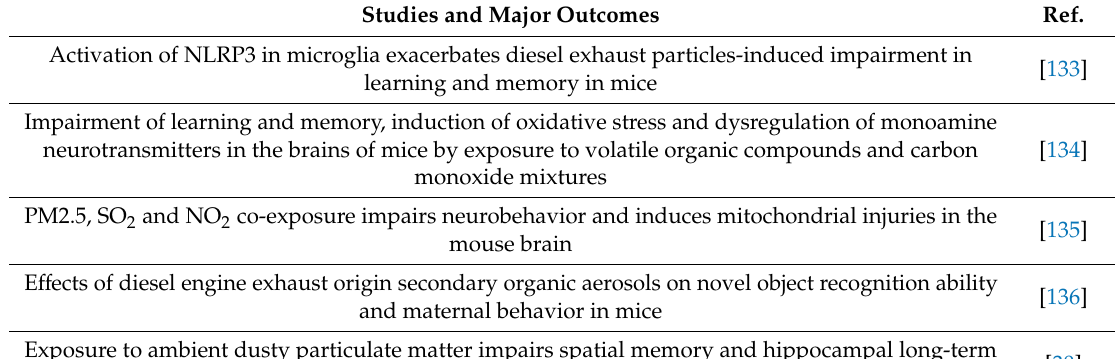
Table 1. Cont. Studies and Major Outcomes